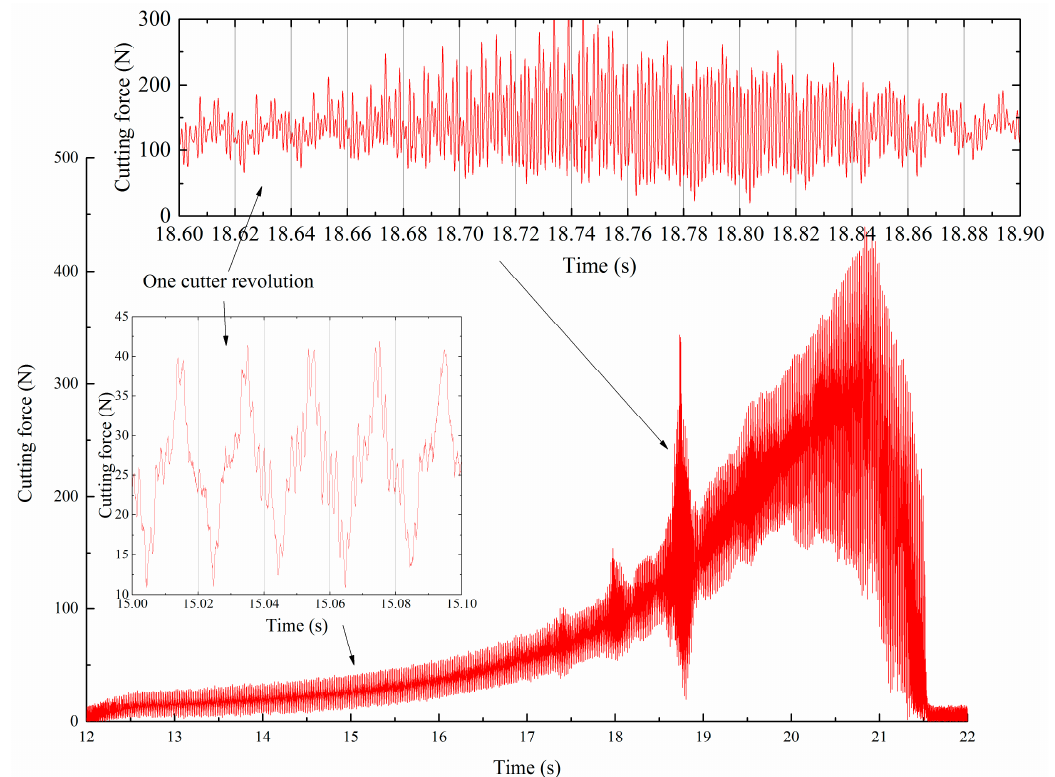
Figure 12. Measured cutting force during the machining of a thin-walled workpiece.